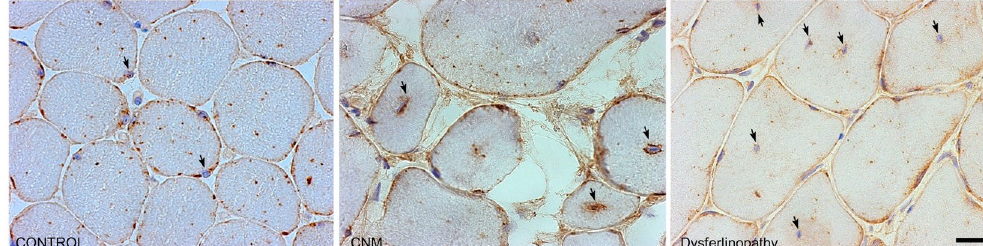
Figure 7. Abnormal perinuclear accumulation of GLUT4 in CNM skeletal muscles. Muscle biopsies from one non affected subject (control), one patient carrying the dynamin-2 mutation p.R465W (CNM) and one patient harboring a mutation in dysferlin (dysferlinopathy) were immunolabeled with a specific antibody against GLUT4 and visualized by field microscopy. In the control biopsy (left panel) GLUT4 staining is observed in sarcolemma and sarcoplasm without any particular distribution. A similar GLUT4 distribution is observed in the disferlinopathy samples (right panel); note that, even in fibers in which nuclei are centrally located (black arrows), there is not GLUT4 accumulation near nuclei in the disferlinopathy biopsy. In the CNM patient biopsy (middle panel) GLUT4 is at the sarcolemma, but strongly concentrates around nuclei in fibers with nuclear centralization (magnification